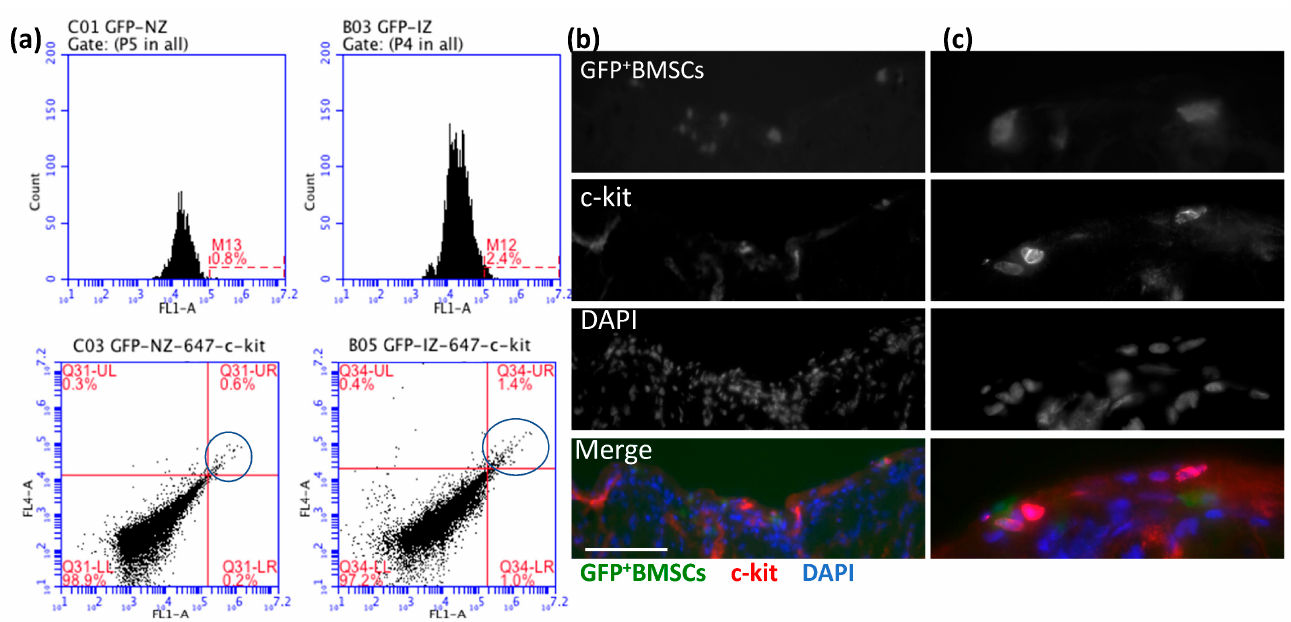
Figure 5. GFP + or GFP + c-kit + bone marrow-derived stem cells (BMSCs) presented in the normal zone (NZ) and ischemia zone (IZ)/collateral dependent zone (CZ) of chimeric rat hearts. ( a ). Flow cytometric analyses of the heart of GFP + BM chimera after 10-day RI. Left: NZ GFP + cells are 0.8% and c-kit + 0.6%. Right: IZ GFP + cells are 2.4%, and c-kit + cells are 1.4%. Blue circles denote c-kit+ fractions. ( b ). Transplanted GFP + BMSCs engrafted in the CZ of a chimeric rat heart expressed c-kit imaged by confocal microscopy. Green shows GFP + BMSCs. Red shows c-kit + cells. Blue shows nuclei. The scale bar equals 100 µm. ( c ). High magnification images of ( b ).